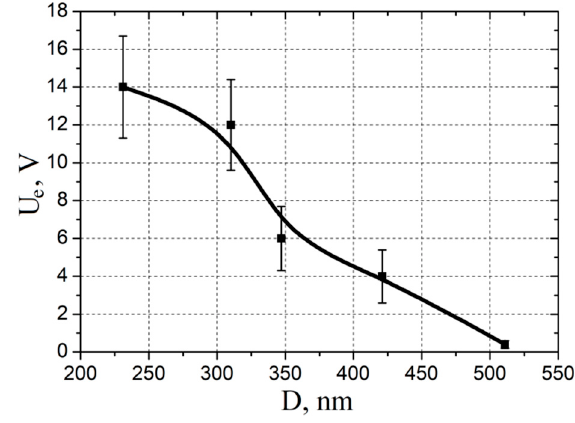
Figure 6. Experimental investigation of the electroforming voltage effect on the grain diameter.